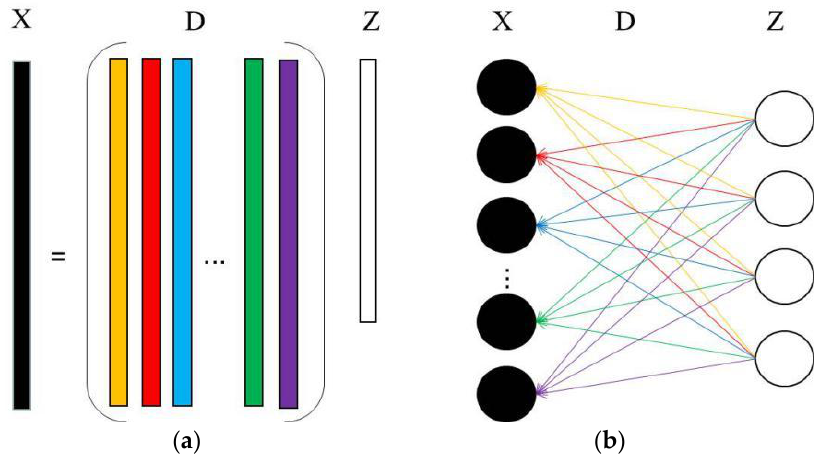
Figure 2. Relationship between dictionary learning and neural network representation. ( a ) Dictionary learning; ( b ) Neural network representation.